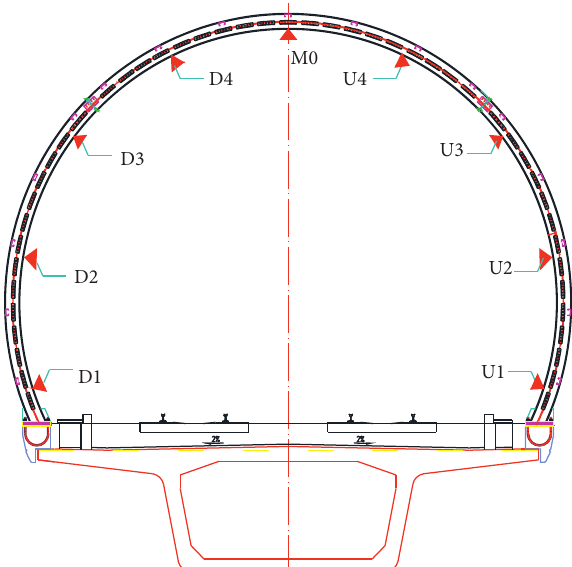
Figure 14: Layout of the measurement